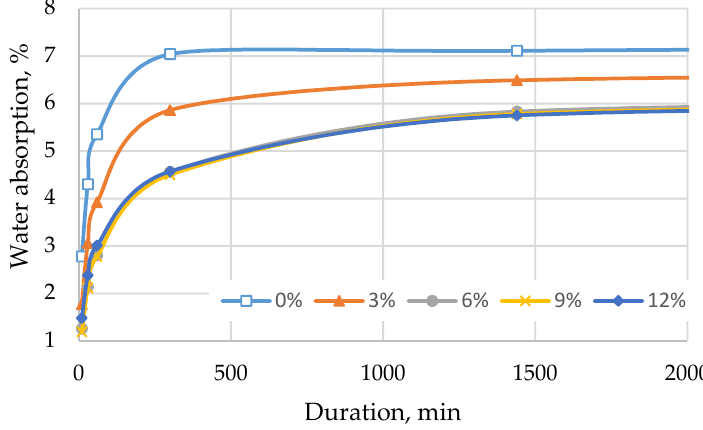
Figure 8. Water absorption when a part of cement is replaced with TS.